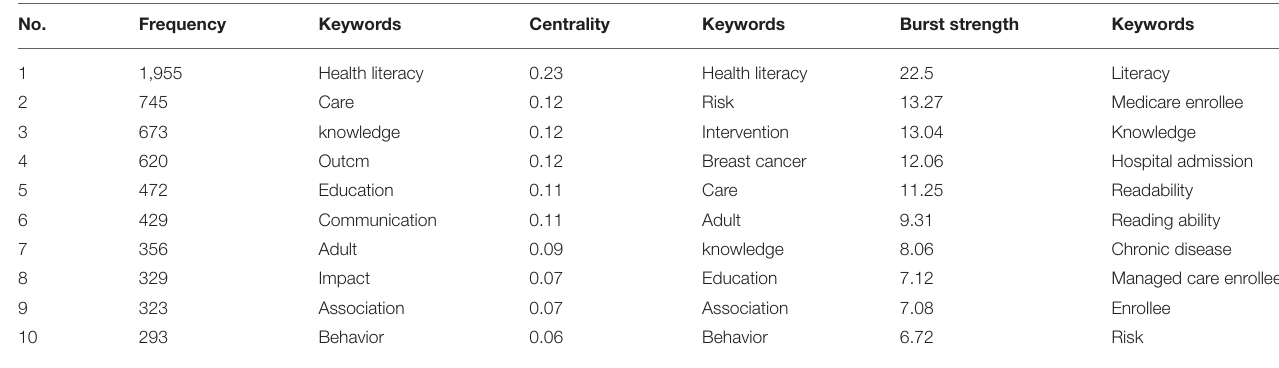
TABLE 6 | The top 20 keywords with high frequency, centrality and burst strength in health literacy.